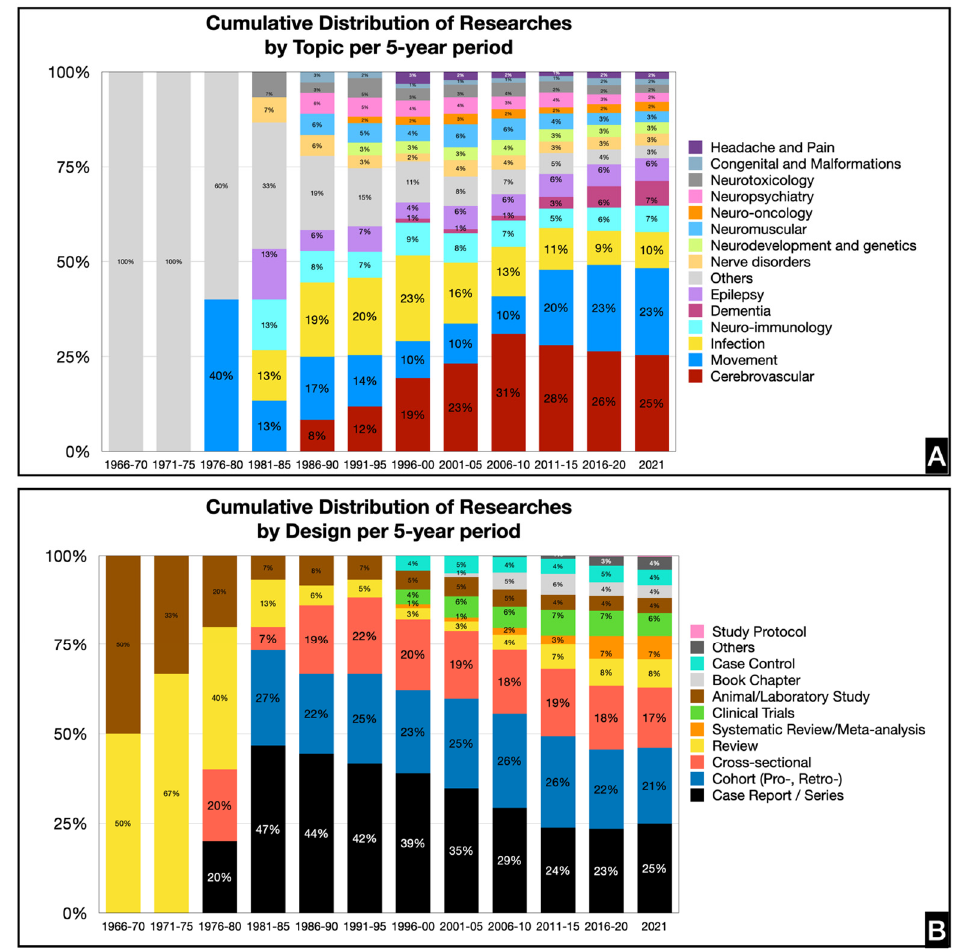
Figure 4. Trends in research publications of Filipino neurologists per 5-year period by research topic ( A ) and by research design ( B ).